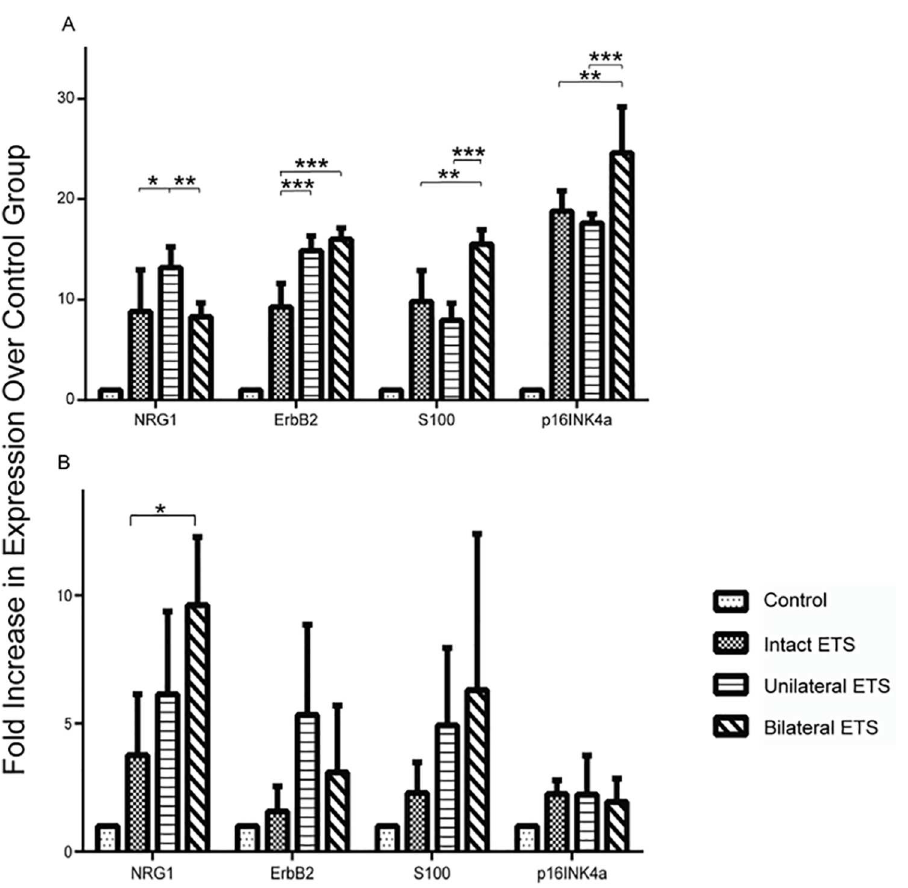
Fig 5. Quantification of Schwann cell migration related gene expression in acellular nerve allografts. A) Two weeks after surgery. The expressionof all genesin every end-to-side (ETS) group was upregulated comparedwith the control group (n = 5 per group). The expressions of S100 and p16 INK4a increasedthe most in the bilateralETS group. Differences betweencontrol and the other groups were significant.B) Four weeks after surgery. The expressionof NRG and S100 was the high tendencyin the bilateralETS group, followedby the unilateral and intact ETS groups(n = 5 per group). The expressionof p16 INK4a dramatically decreased in all groups. Significantdifferences were only observedbetweenthe intact ETS and bilateral ETS group in NRG1. * p < 0.05, ** p < 0.01, *** p <